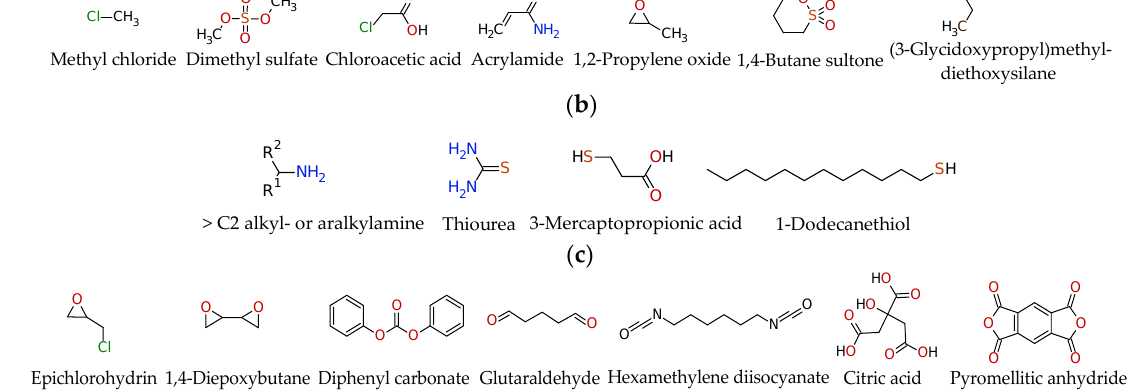
Figure 2. Simplified reaction mechanisms of nucleophilic reactions in solution and a ball mill. ( a ) Nucleophilic substitution in solution; ( b ) Nucleophilic reaction of cyclodextrins in a ball mill; CD: Cyclodextrin; LG: Leaving Group; M: Metal; Nu: Nucleophilic moiety; Q, R’: organic group or hydrogen. The most common reagents used to synthesize CD derivatives are shown in Figure 3. Of the chemicals shown, methyl chloride, 1,2-propylene oxide, and 1,4-butane sultone are used in the several hundred kilograms to ton- scale production of βCD derivatives, while tosyl chloride and dimethyl sulfate are for the several kilograms scale CD derivati- zation. In the kg-scale preparation of Sugammadex ® , 3-mercaptopropionic acid reacts with octakis(6-deoxy-6-halogeno)- γCD. Epichlorohydrin is the most common crosslink- ing agent for soluble and insoluble CD polymers. Other reagents are mostly limited to the experimental laboratory scale and rarely exceed ten to one hundred gram production batches.